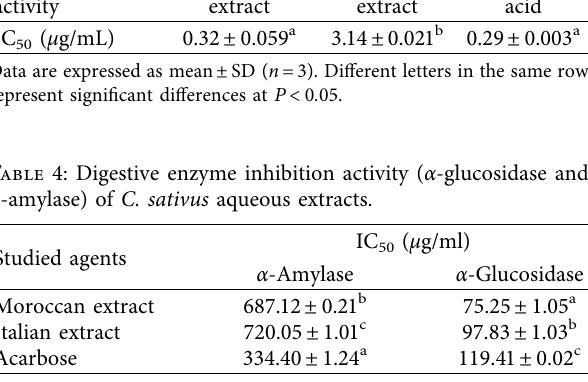
Table 3: Free radical scavenging activity of C. sativus extract. Antioxidant activity